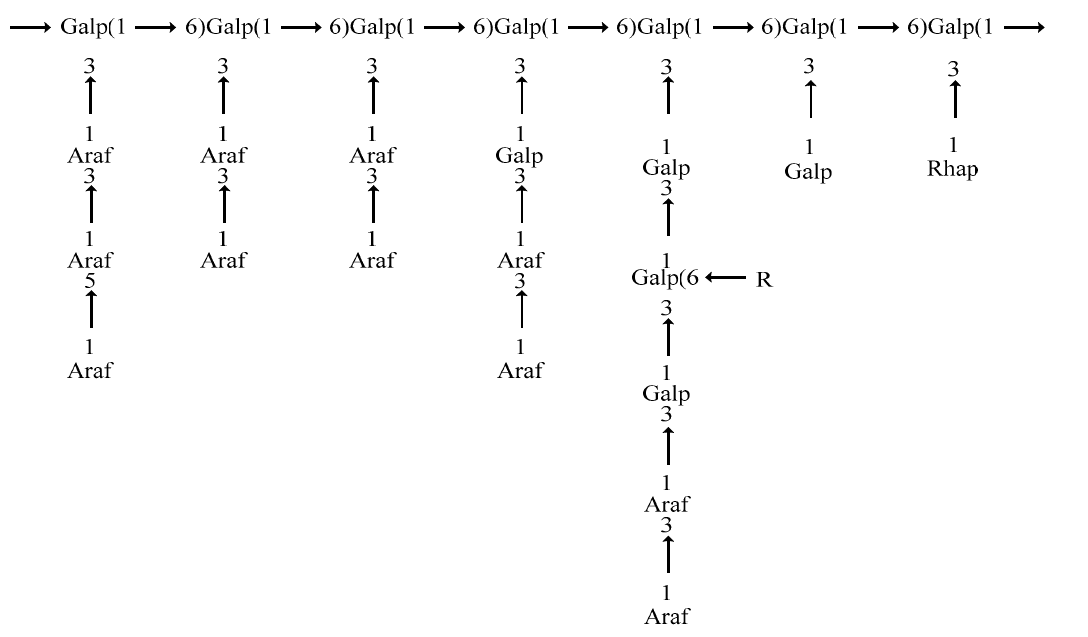
Figure 8. Schematic representation of the structural unit of LRP4-A.